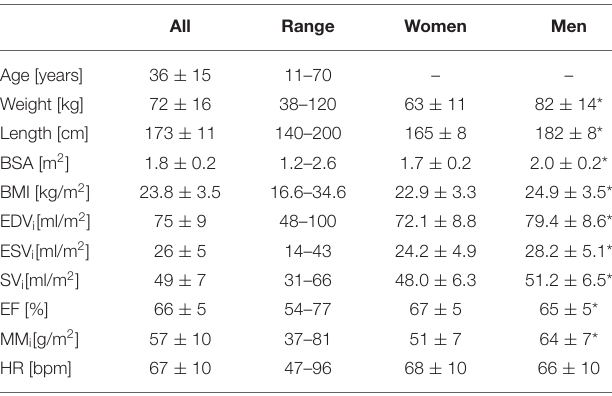
TABLE 1 | Baseline characteristics of healthy participants. All Range Women Men